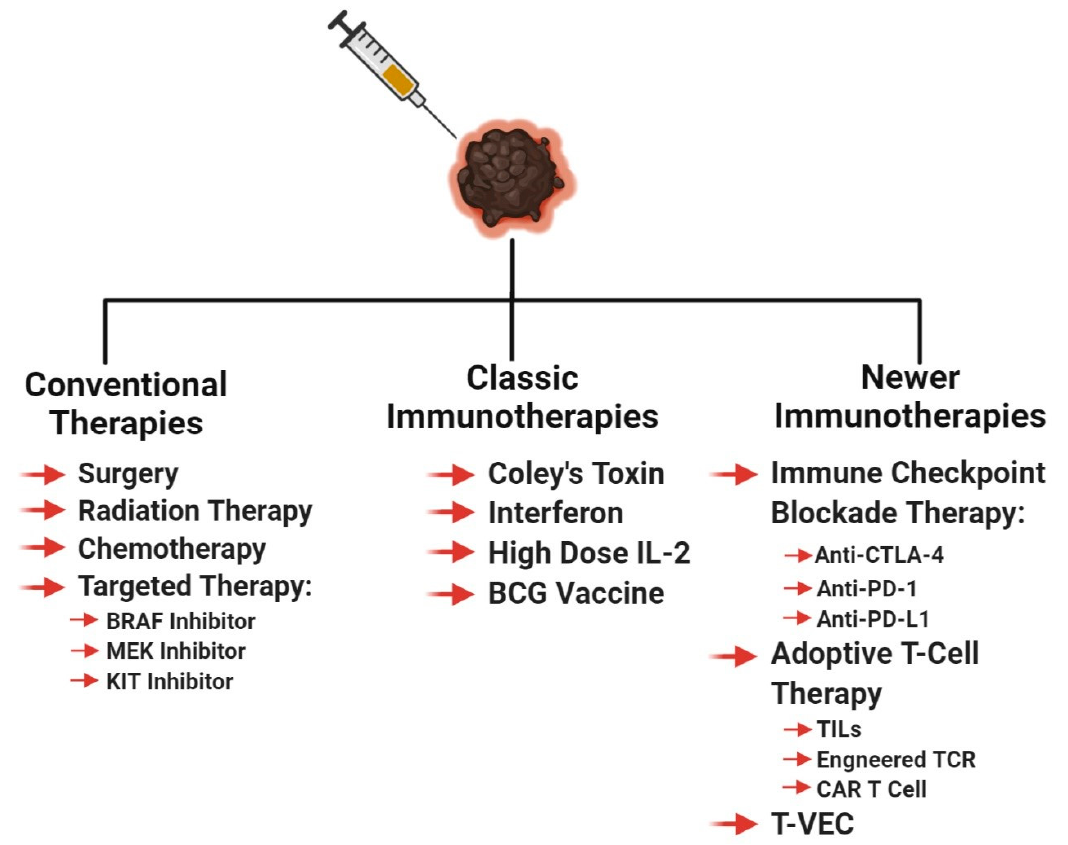
Figure 2. Various melanoma therapies used in the clinic. These therapies include